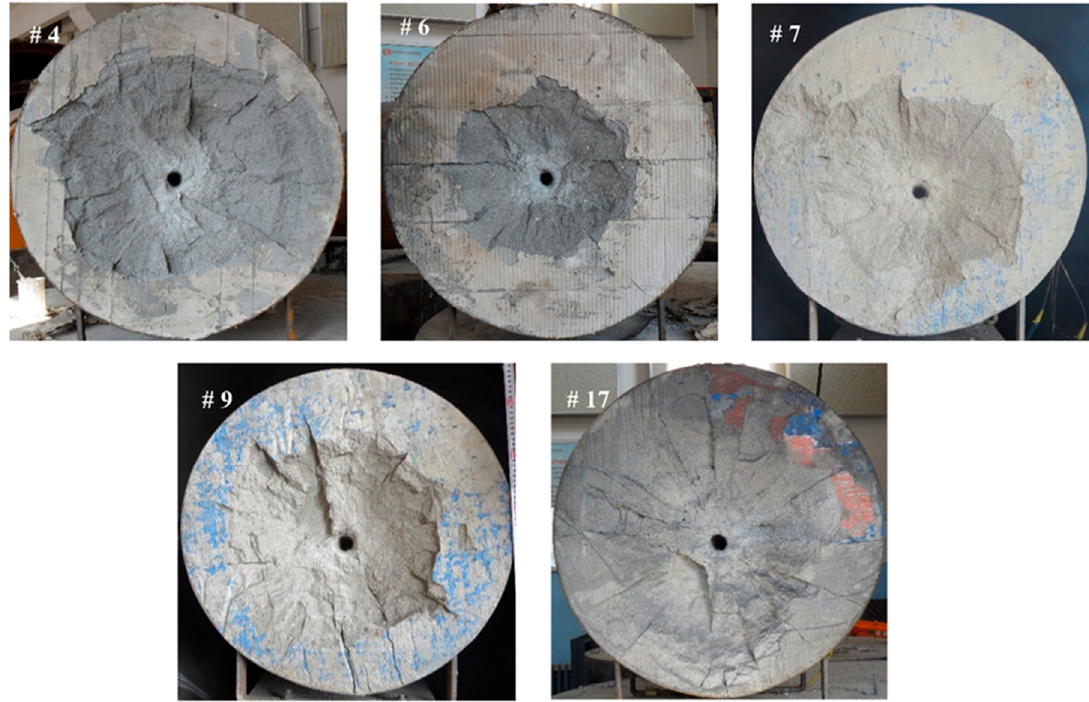
Figure 5. Frontal damage of concrete targets.